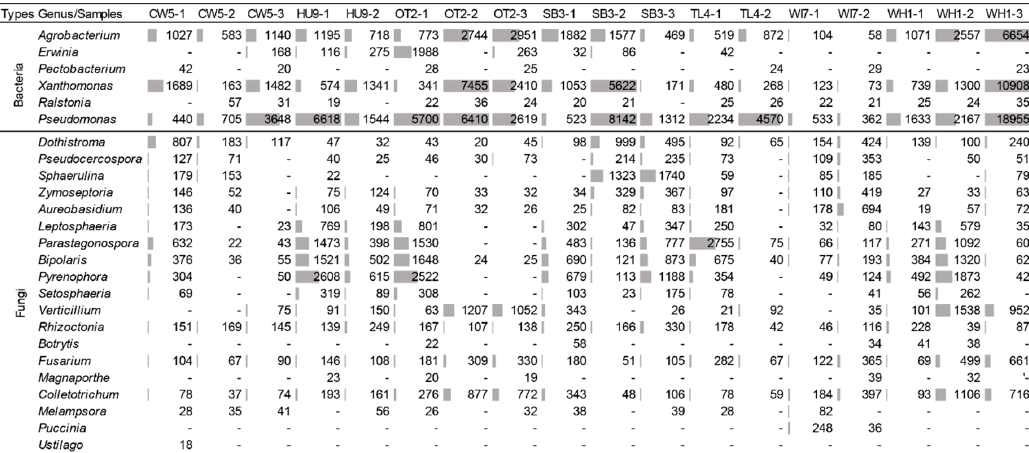
Figure 3. Genera representing potentially pathogenic bacteria and fungi on S. kraussiana exhibiting signs of disease at nine locations.